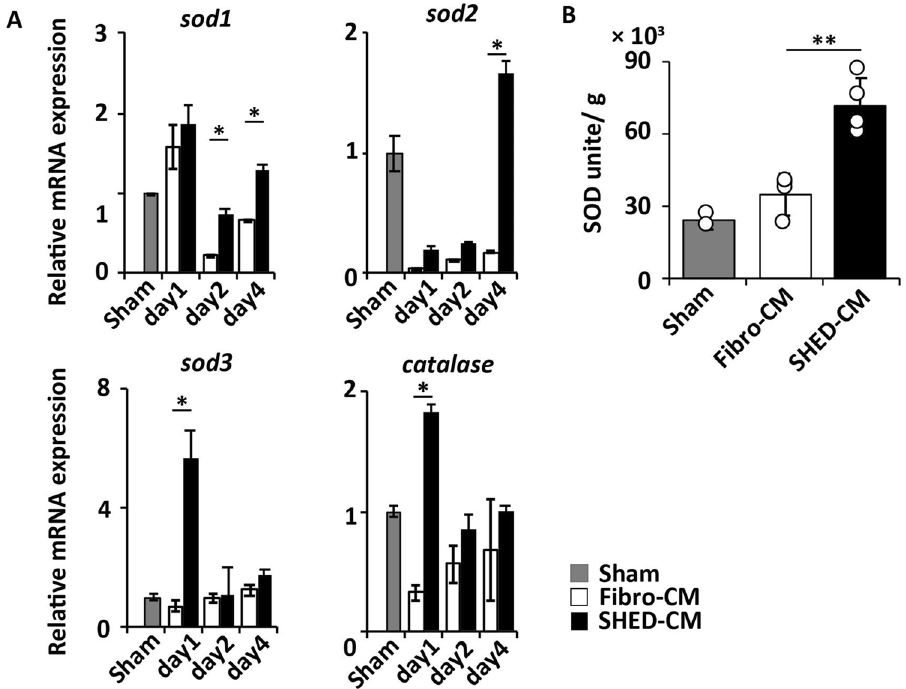
Figure 5. SHED-CM increases the expression of antioxidant enzymes in irradiated SGs. ( A ) Chronological quantitative real-time polymerase chain reaction analysis of indicated mRNAs in irradiated SGs treated with SHED-CM or Fibro-CM (n = 3). ( B ) The SOD activities of the irradiated SG 24 h after the last CM treatment (n = 4). Data are represented as mean ± SD. Comparisons between groups were analyzed using an unpaired